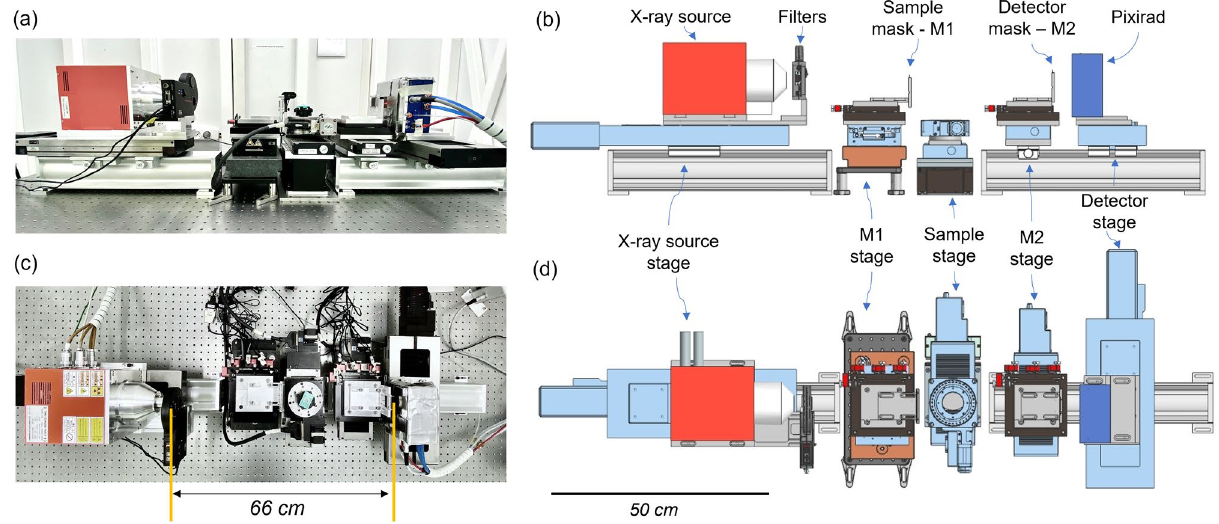
Figure 5. Lateral ( a ) and top ( c ) view photographs of the setup and their respective CAD drawings ( b , d